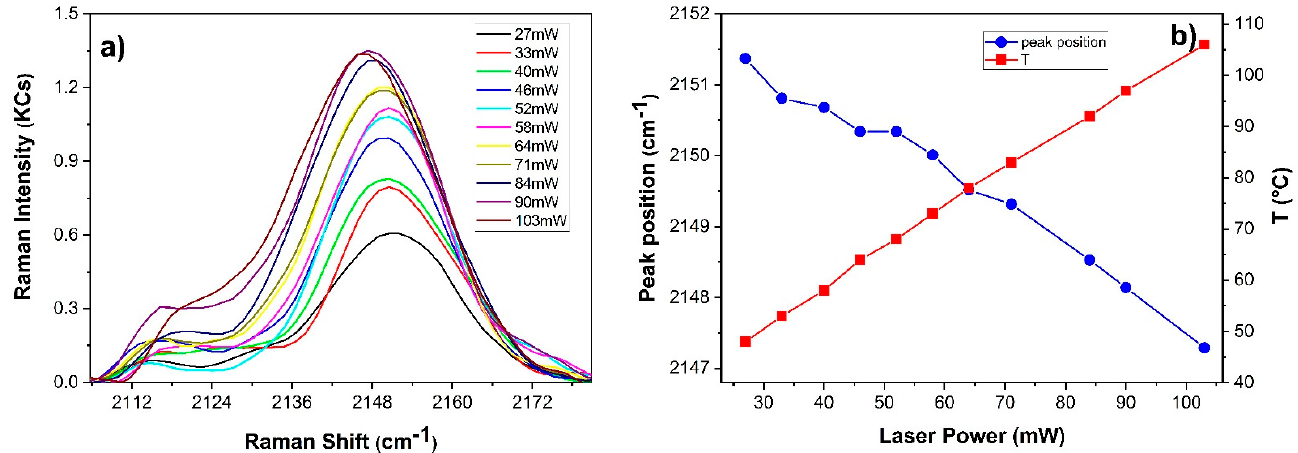
Figure 8. ( a ) Spectral detail of the CN stretching band ( ≈ 2150 cm − 1 ) at increasing power; ( b ) Corresponding variation of the central wavenumber and temperature after 60 s laser irradiation.